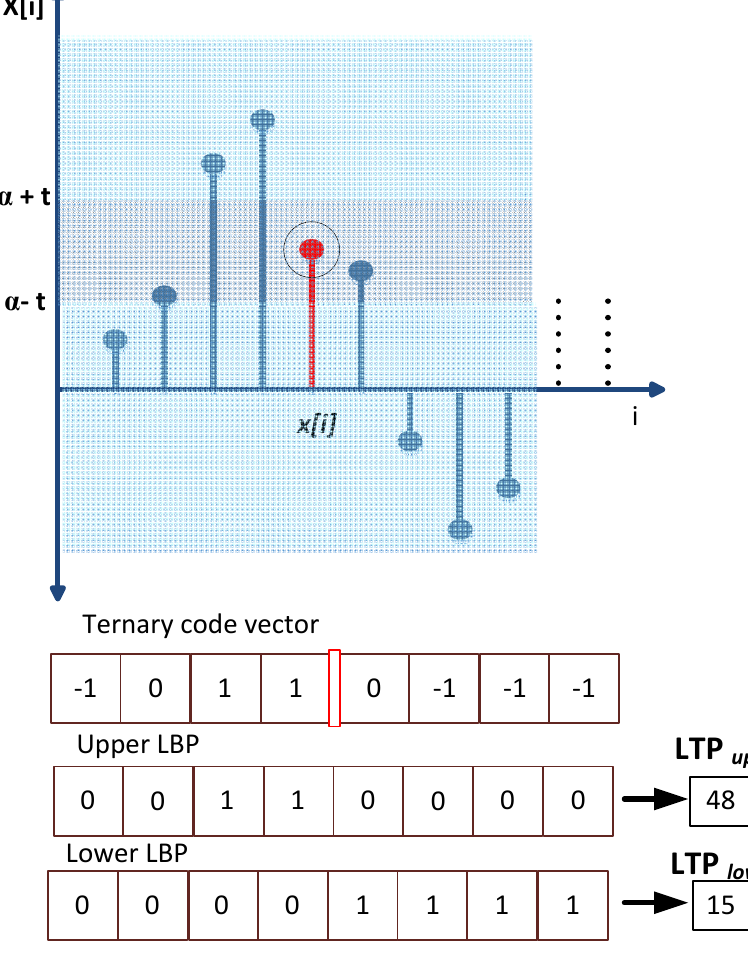
Figure 2. Extraction of 1D-LTP